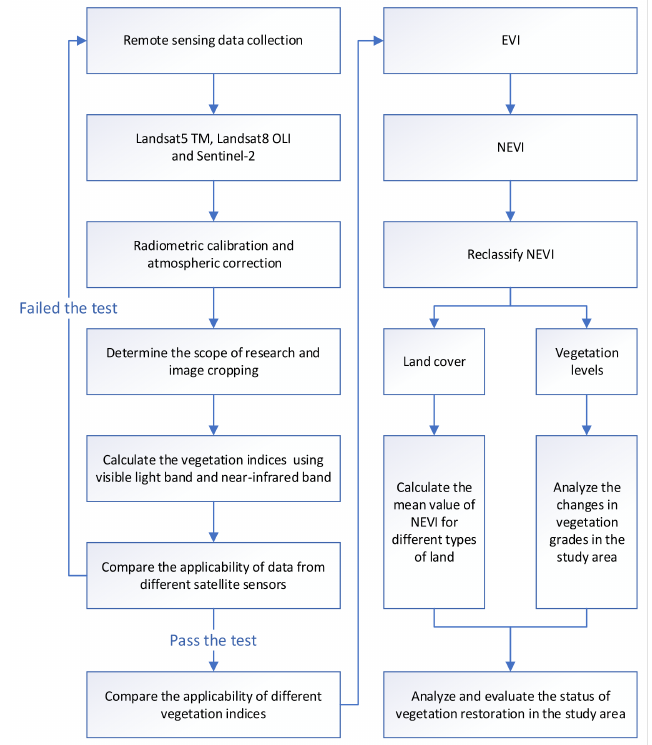
Figure 2. The main work–flow chart of data processing and